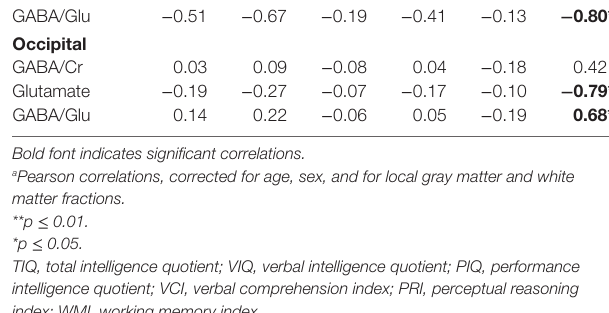
Metabolites cognition